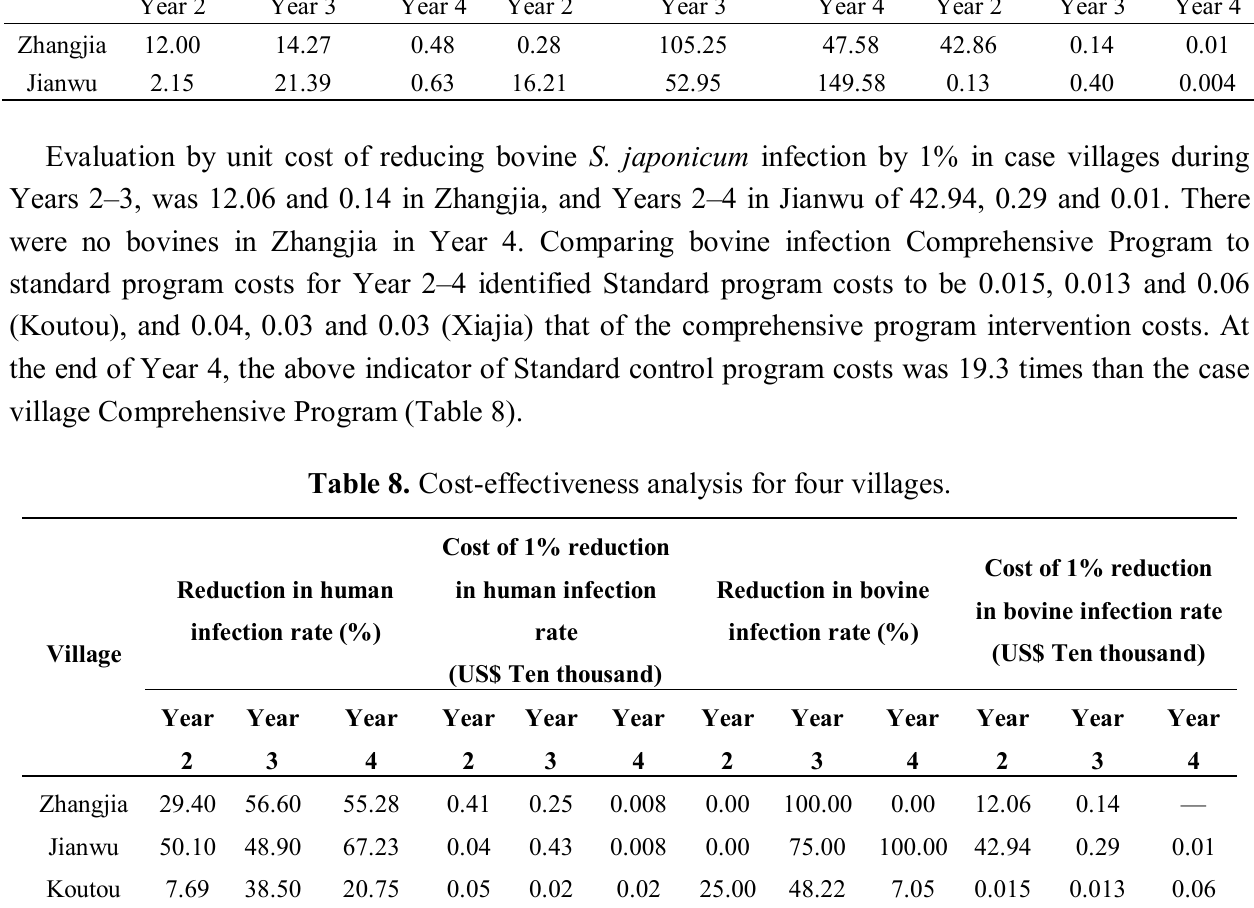
Table 7. Analysis of the comprehensive effectiveness in experimental villages. Villages